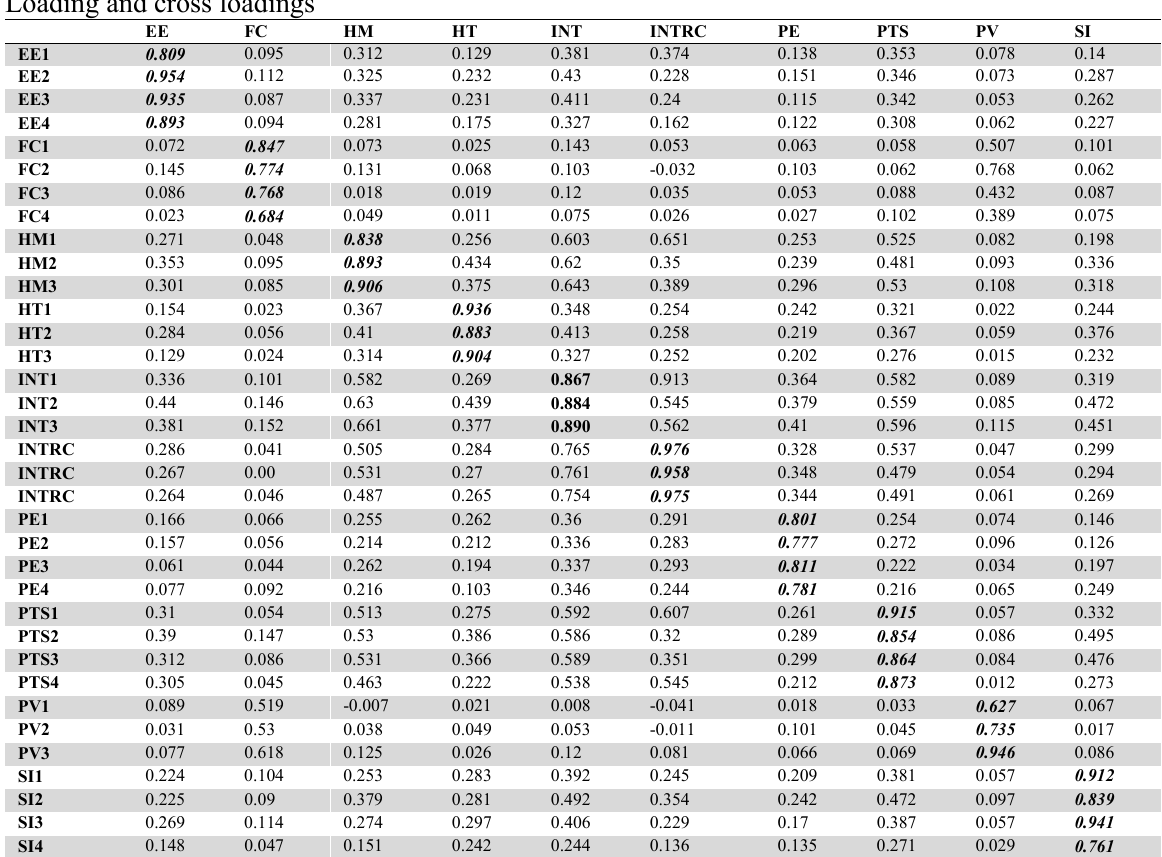
Loading and cross